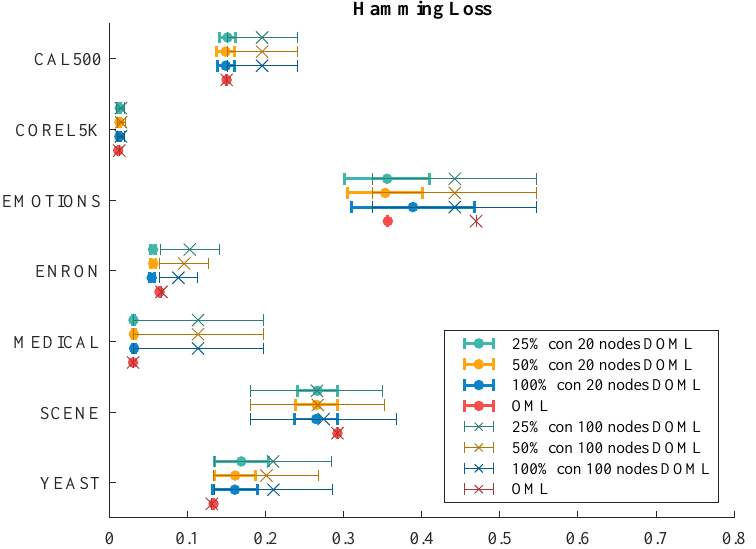
Figure 5. Hamming loss of DOML in a 100-node network with different connectivity and OML with same amount of instances as each